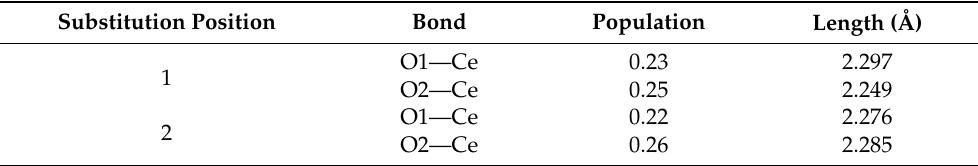
Table 5. Mulliken populations after the substitution of Ce by La at positions 1 and 2.